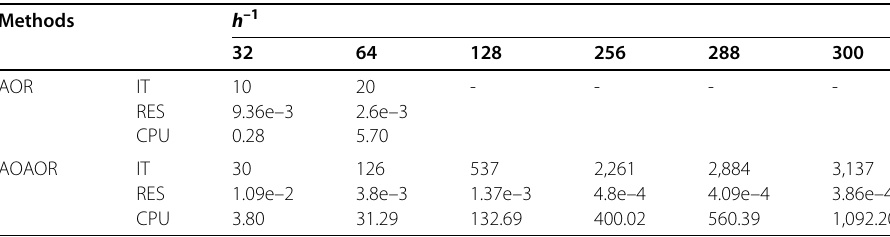
Table 5 Numerical results when ξ = 0.0, ζ = 30.0, σ = 10.0 ( ε = h 2 )